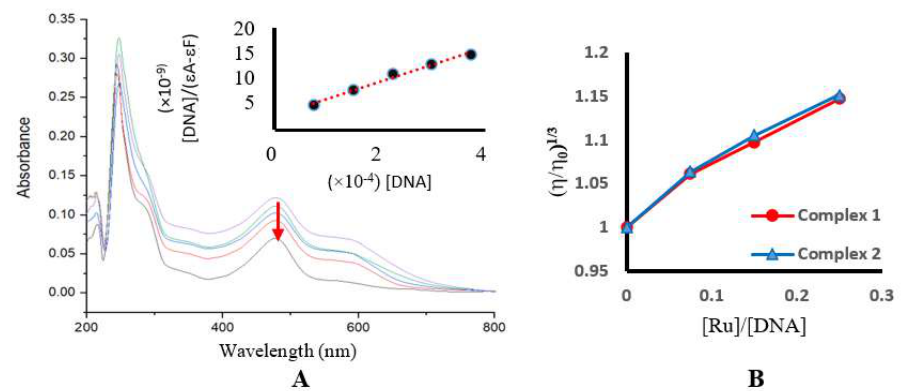
Figure 3. ( A ) The UV–vis spectroscopic changes at 482 nm of complex 3 upon increasing the concentration of CT-DNA. ( B ) The changes in the relative viscosity of DNA upon additions of different concentrations of complexes 1 and 2 .